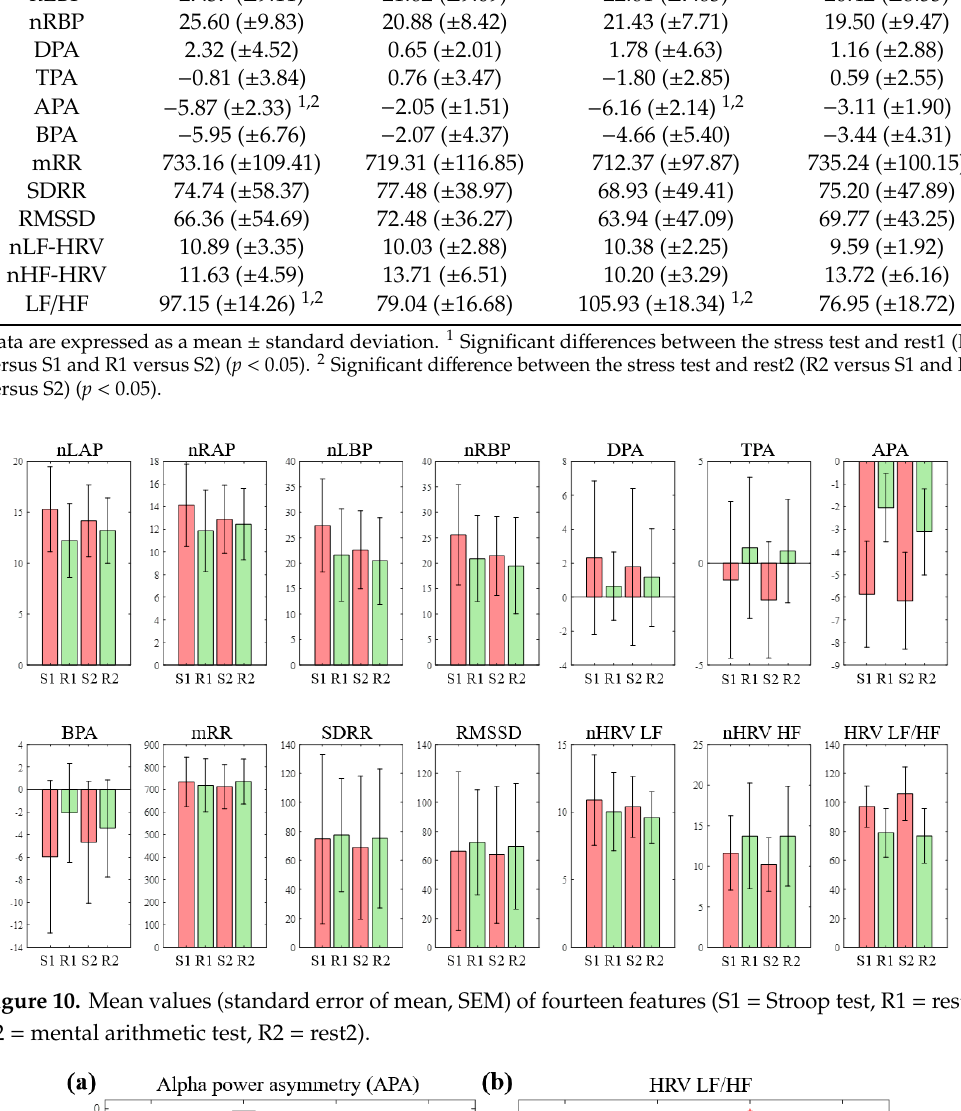
Figure 10. Mean values (standard error of mean, SEM) of fourteen features (S1 = Stroop test, R1 = rest1, S2 = mental arithmetic test, R2 = rest2).